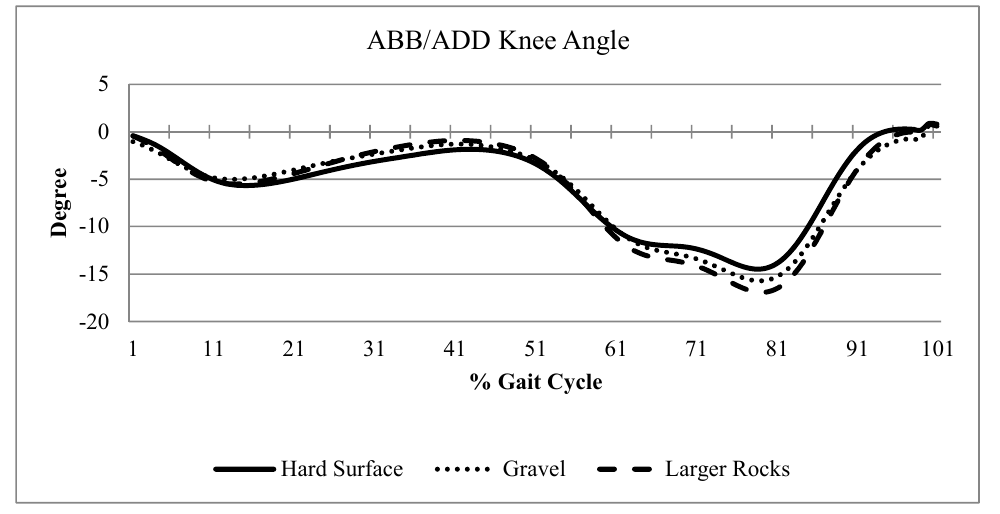
Figure 4. ( a ) Mean knee abduction/adduction angle by surface type (combined level and slope); ( b ) mean knee rotation angle by surface type (combined level and